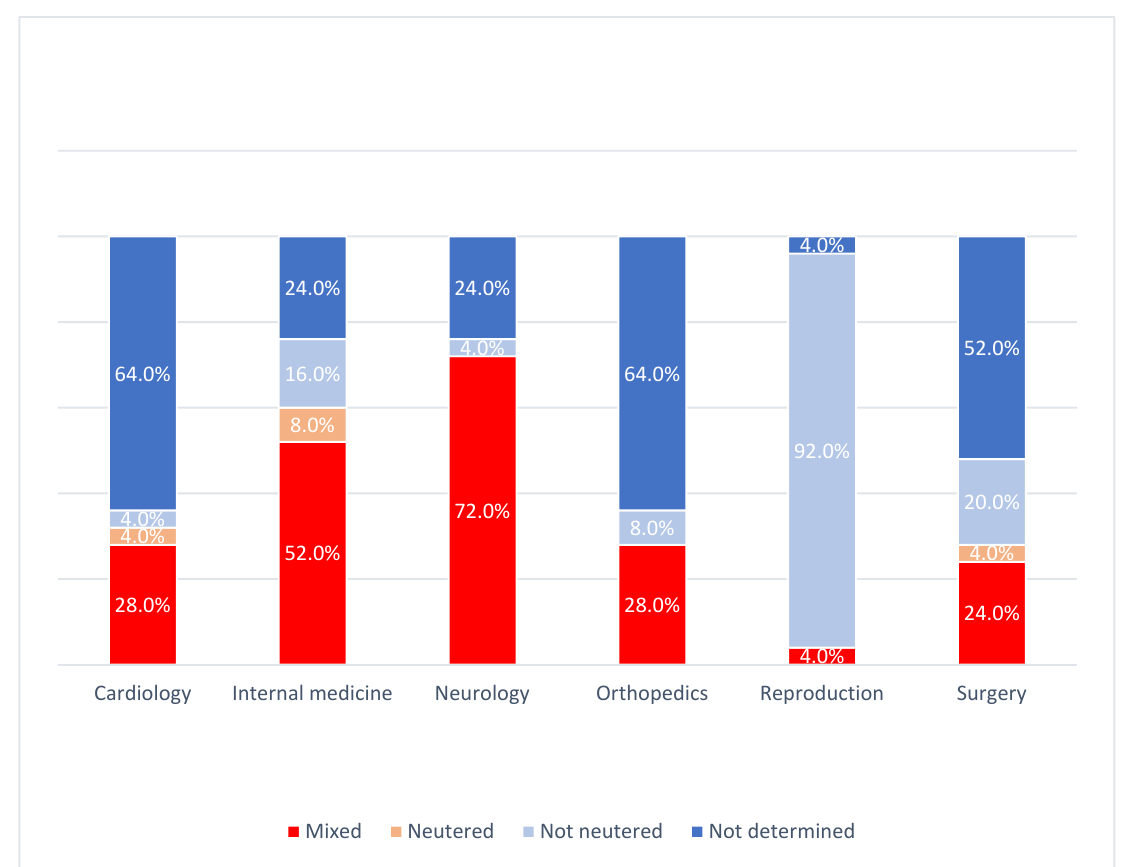
Figure 2. Spay and neuter status of the dogs utilized in 150 clinical trials within six veterinary specialties (25 each).